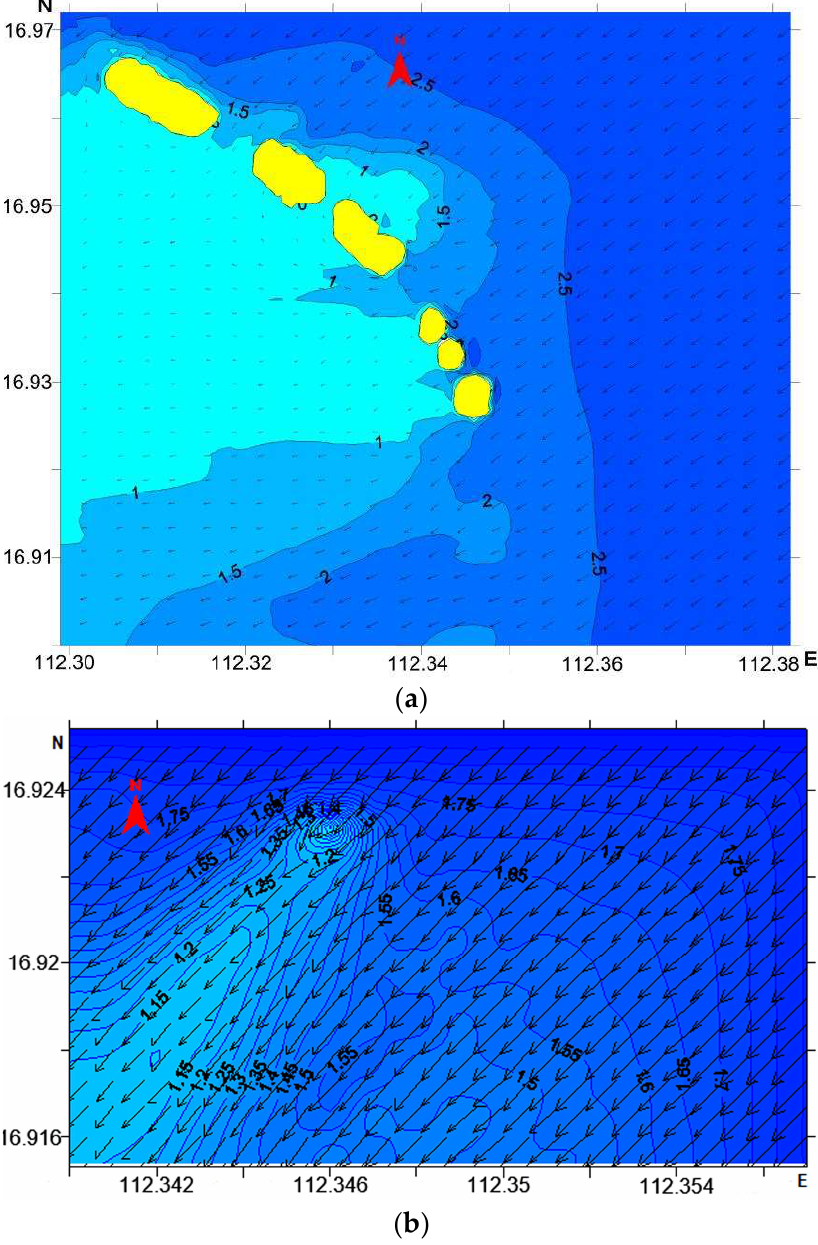
Figure 7. Wave vector diagram in the strong wave direction (NE) around the Qilianyu ( a ) and Wave vector diagram in the strong wave direction (NE) around the newborn sandbank ( b ).